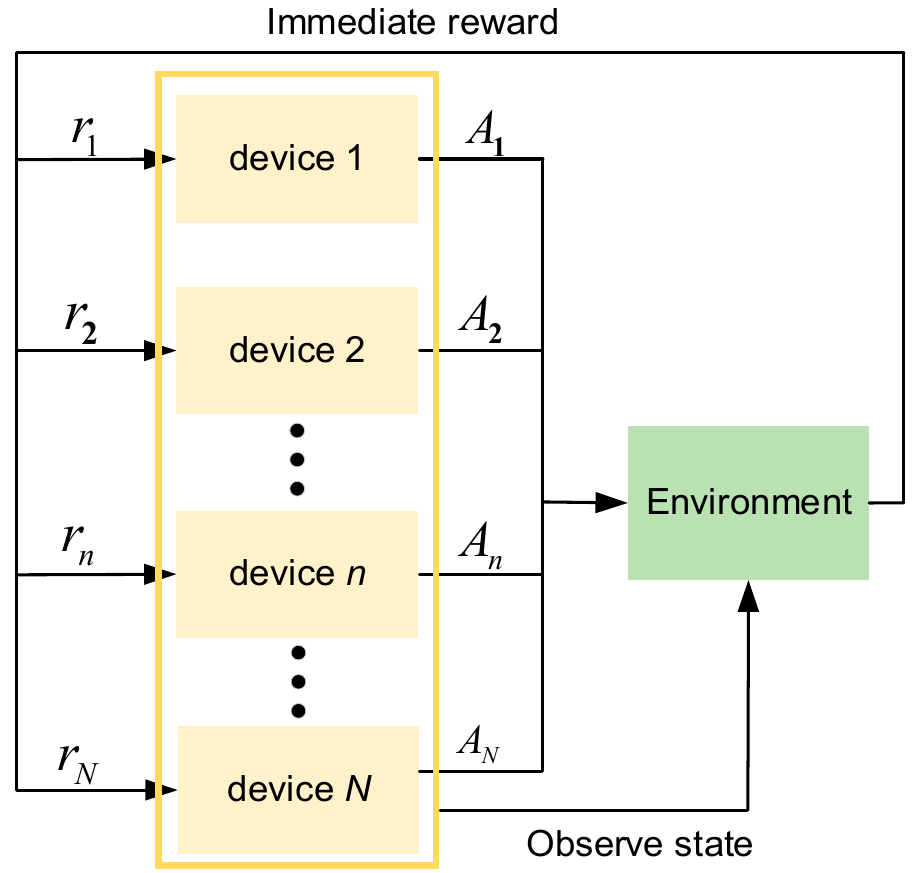
Figure 3. The Q-learning framework for proposed edge-assisted FL.